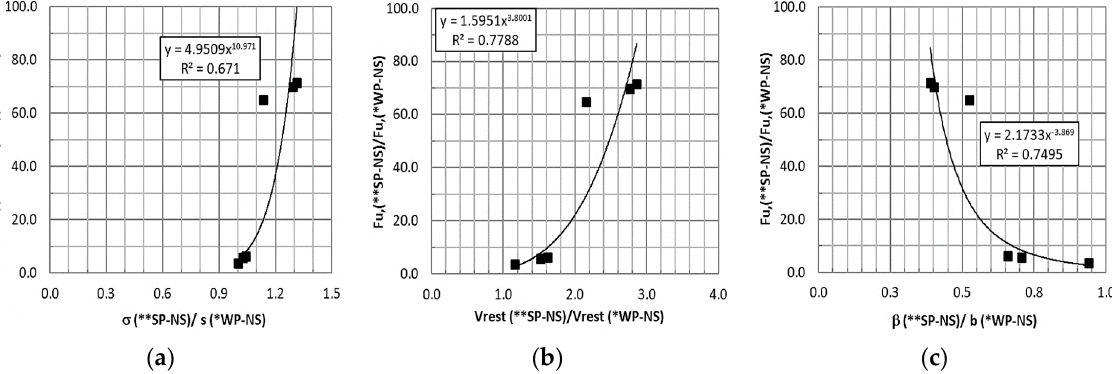
Figure 20. Ultimate capacity for SP-NS and WP-NS [15] as a function of yield strength ( a ), resting volume ( b ), and plate slenderness ratio ( c ).